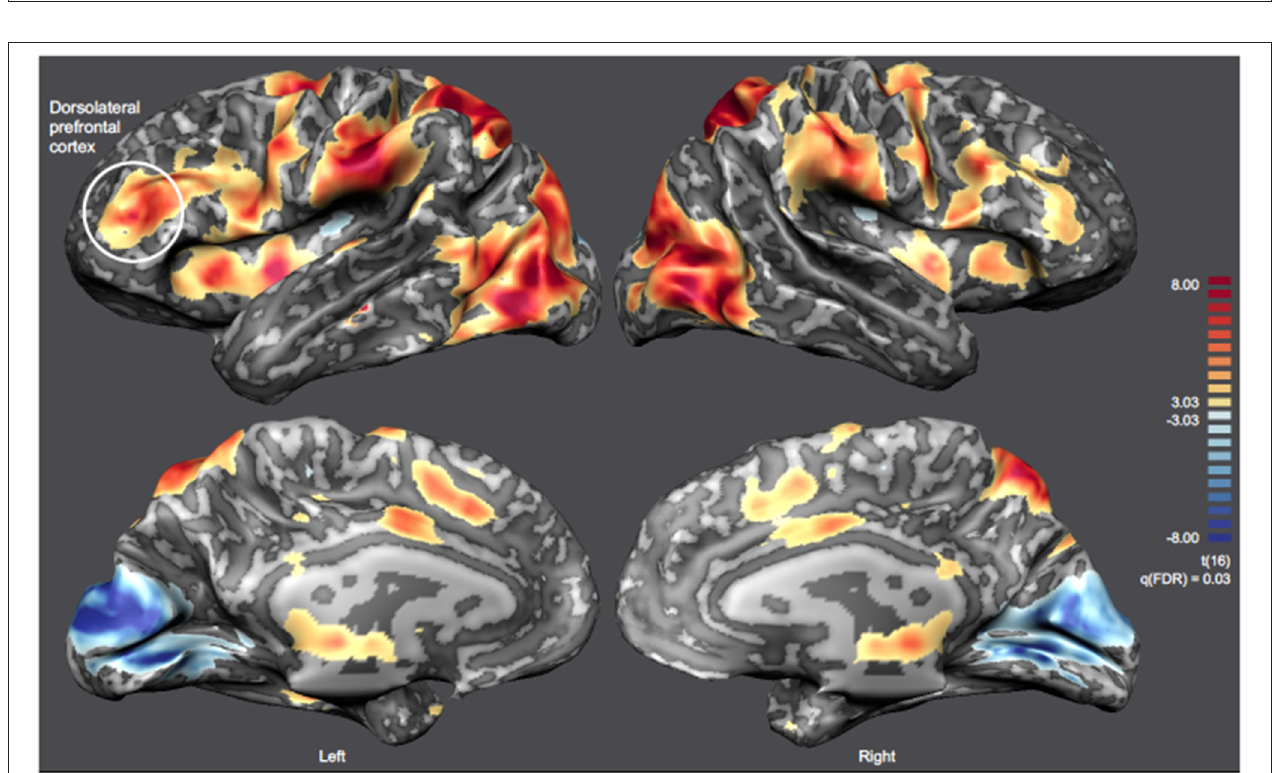
FIGURE 7 | Inflated cortex representation of the statistical map corresponding to the contrast Pain Images > Neutral Images [RFX-GLM, q(FDR) = 0.03] of the localizer run. The neurofeedback target (left DLPFC) is highlighted and the remaining clusters are summarized on Supplementary Table 2 .